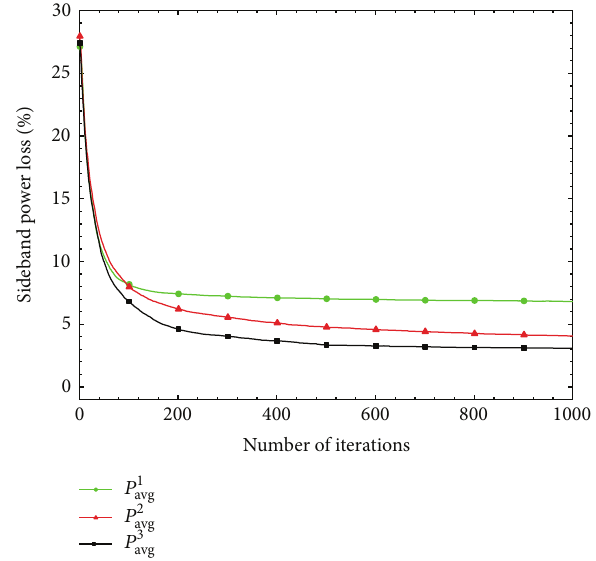
Figure 24: Power loss percentage variation of the three methods for JSCIS— 𝑃 𝑘 represents the power loss percentage and 𝑘 represents the method used, where 𝑘 = 1 : SBL, 𝑘 = 2 : SR, and 𝑘 = 3 : SB.